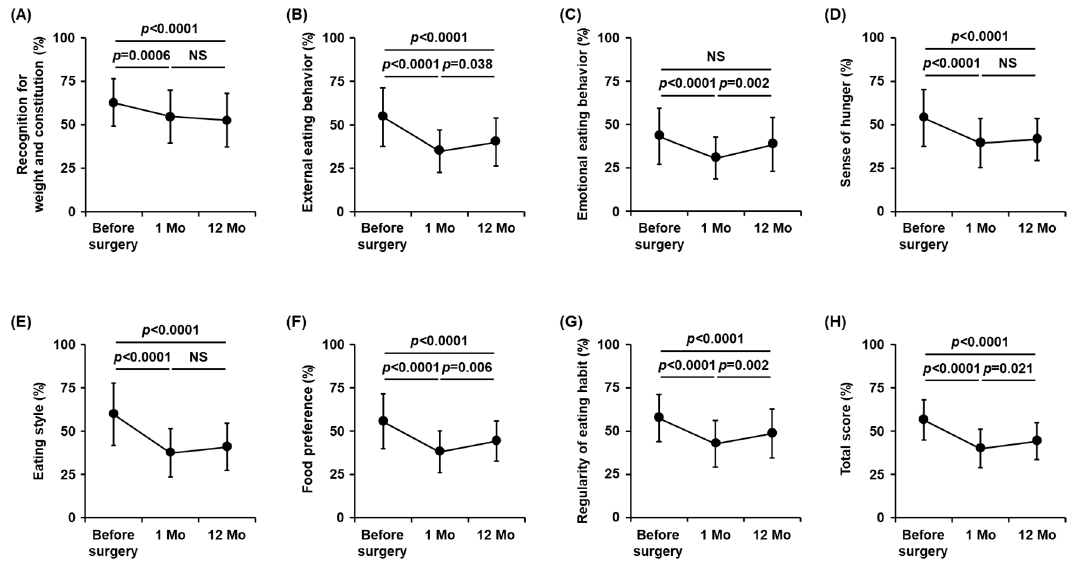
Figure 4. Time-course changes in scores for eating behaviors after surgery. ( A – H ) Changes in each eating behavior were assessed by the questionnaire, as described in the Section 2. Data are the mean ±SD. The p values were calculated using repeated measures ANOVA with Tukey’s post hoc test. Mo, month; NS, not significant.